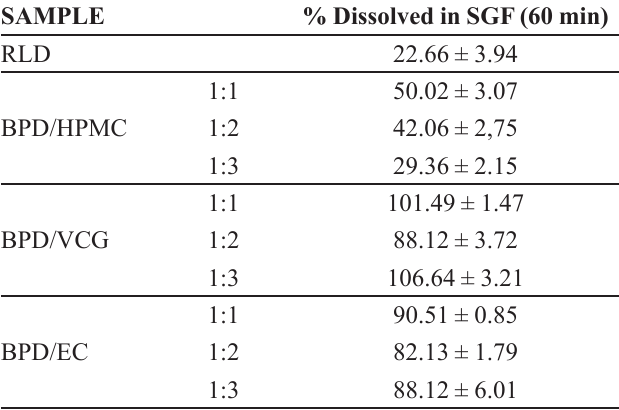
TABLE II - Percentage of BPD dissolved from different sustained-release matrix in SGF after 60 min